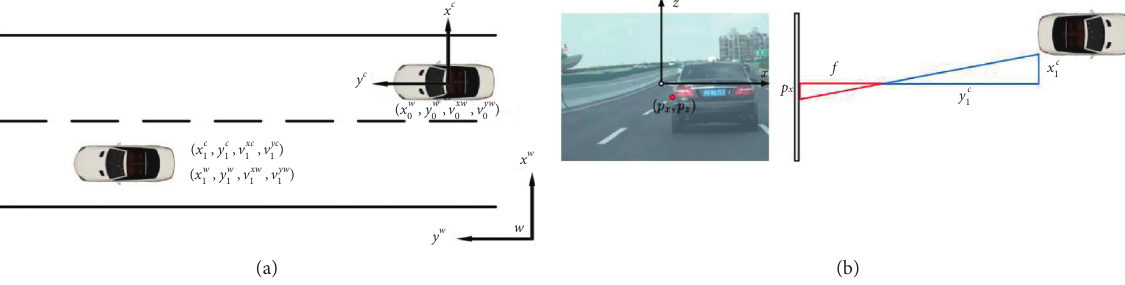
Figure 6: Coordinate relationship between vehicles. (a) Coordinate system conversion. (b) Lateral distance